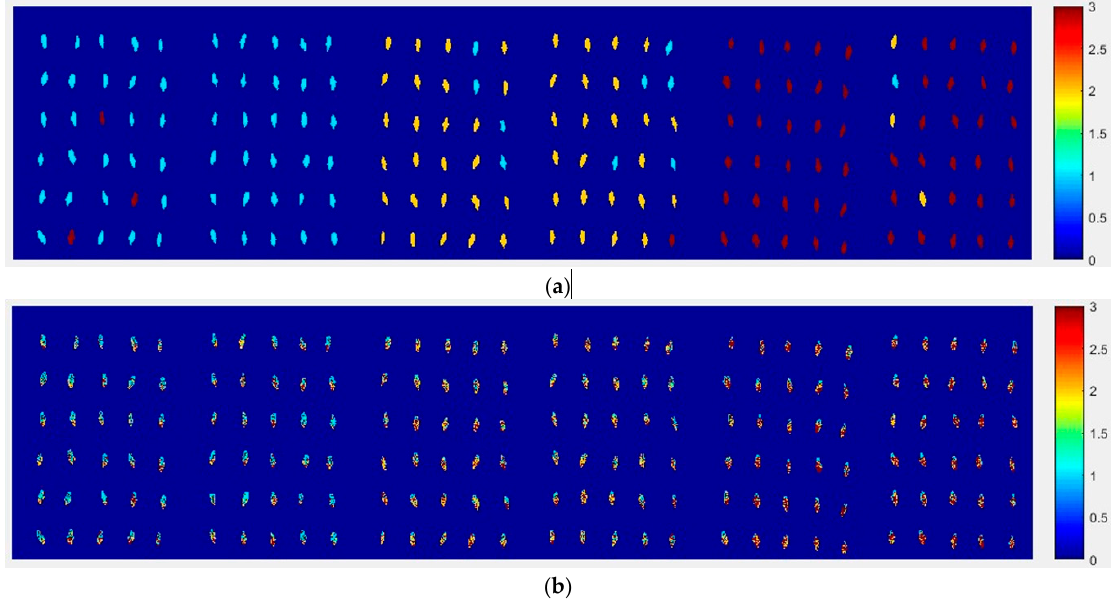
Figure 7. The visualization images of ( a ) method M2M and ( b ) method M2P for Haoyu21 with the SPA and PLS-DA model.